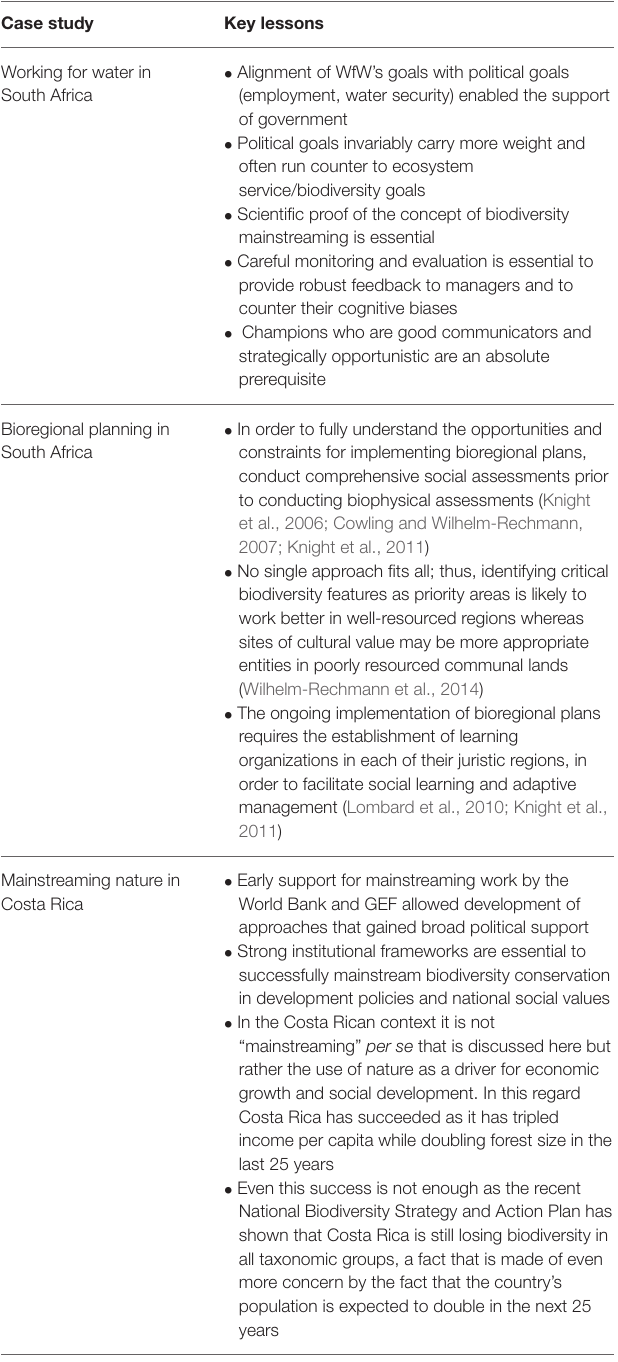
TABLE 2 | Key lessons from mainstreaming case